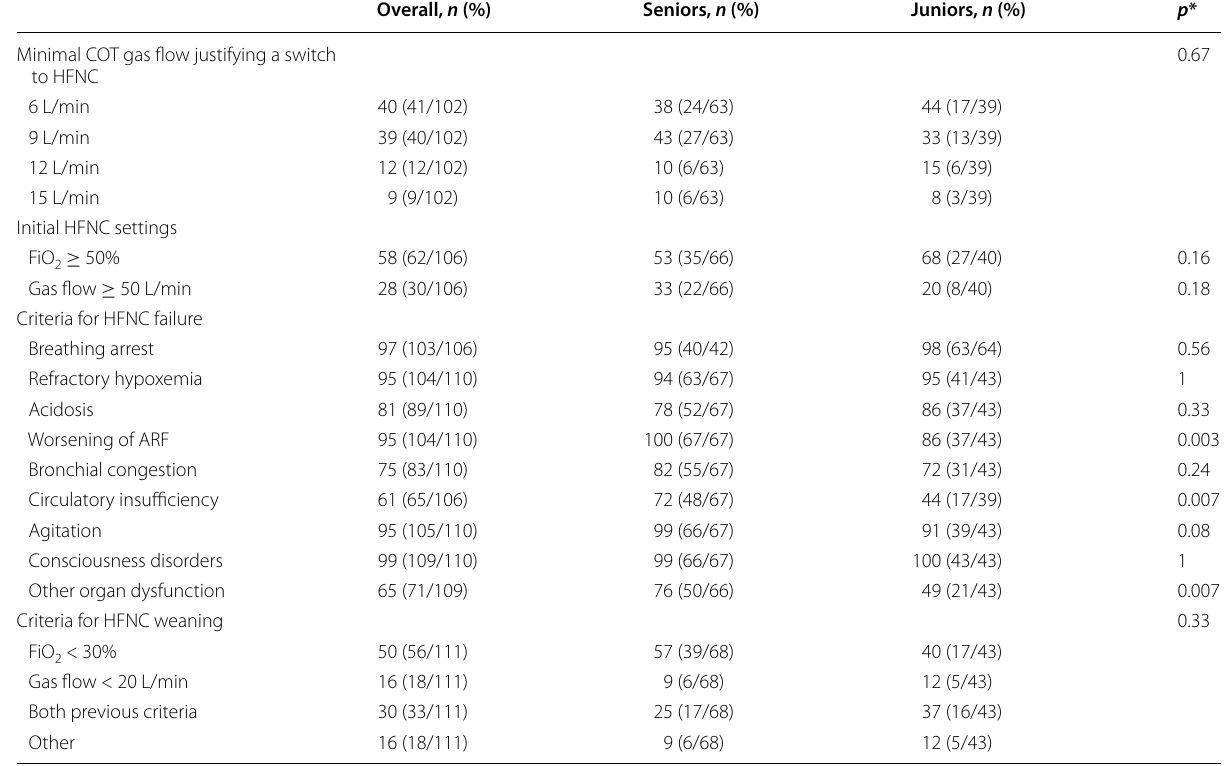
ARF: Acute respiratory failure; COT: conventional oxygen therapy; HFNC: high-flow nasal